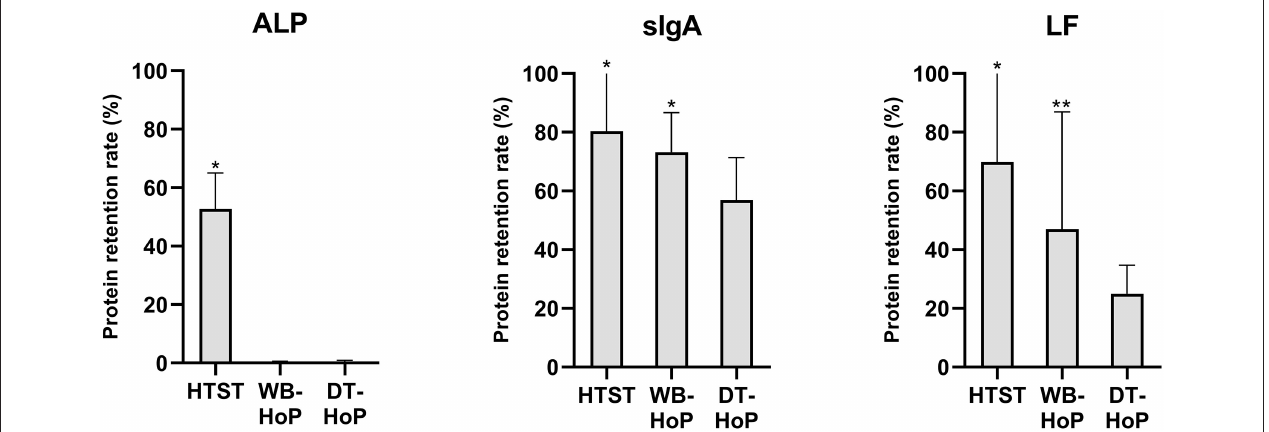
FIGURE 3 | Protein retention rates for alkaline phosphatase (ALP), secretory immunoglobulin A (sIgA) and lactoferrin (LF) after thermal treatment of human milk. HTST, High-temperature short-time (pasteurization); DT-HoP, dry-tempering Holder pasteurization; WB-HoP, water-bath Holder pasteurization. * p < 0.05 (HTST vs. any HoP; WB-HoP vs. DT-HoP), ** p > 0.05 (WB-HoP vs. DT